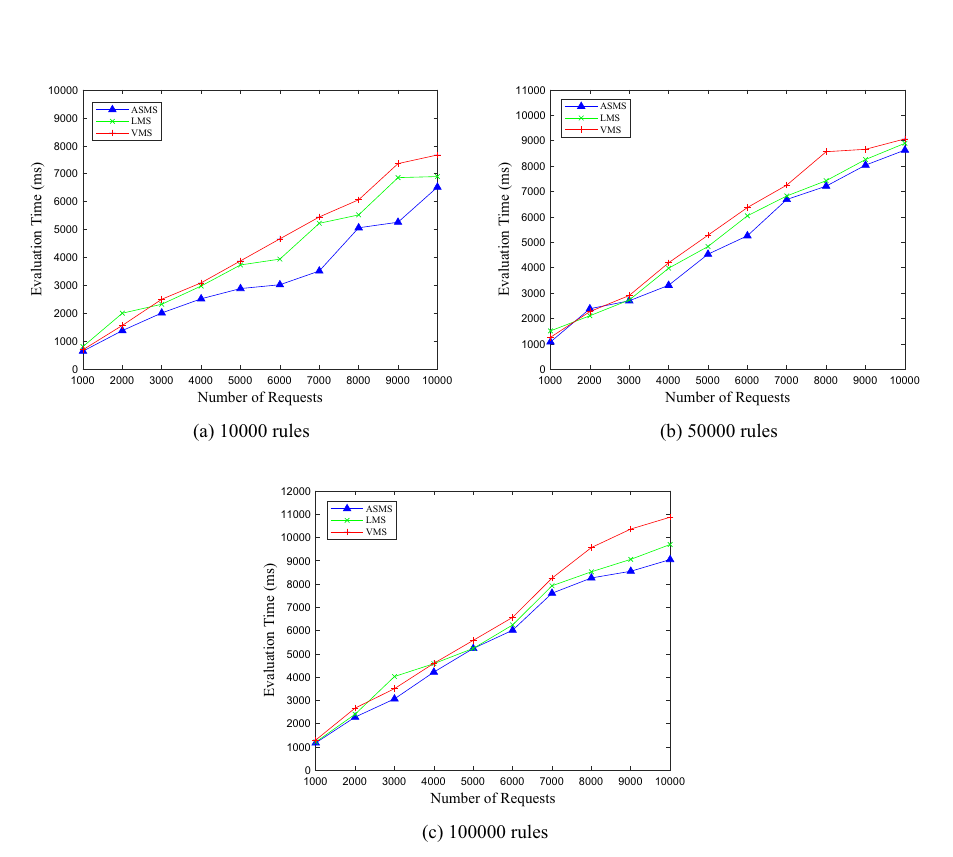
Figure 15. Comparison on different policy